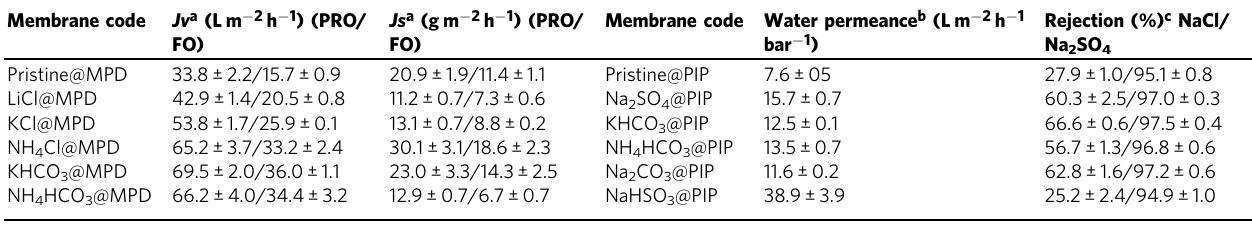
Table 1 FO performance of TFC membranes formed by MPD/TMC modi fi ed with various salts and NF performance of TFC membranes formed by PIP/TMC modi fi ed with various salts (error bars represent standard deviation and were calculated on the basis of at least three data points measured from different